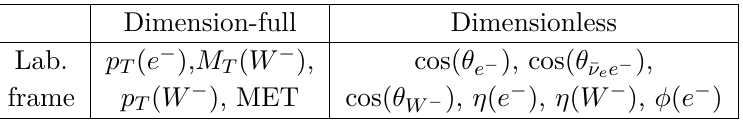
Table 4. Angular and kinematic observables selected to study the single production channel (VLBSM). We compute observables in the laboratory frame. The same nomenclature of table 3 for angles applies